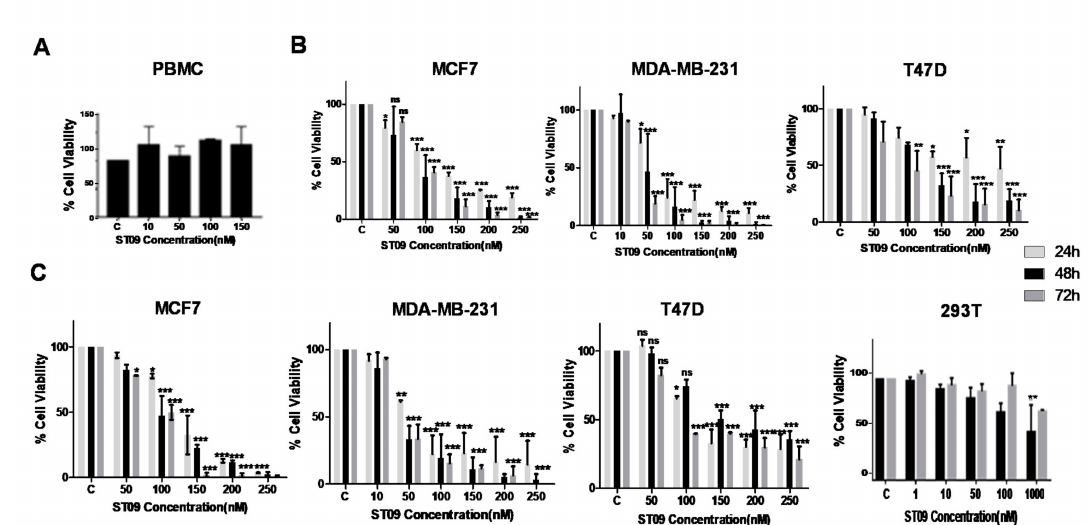
Figure 2. ST09 induced cytotoxicity analysis. ( A ) Viable PBMC cell count after ST09 treatment by trypan blue exclusion: the cells were collected and stained for trypan blue uptake after 48 h treatment with ST09. The unstained viable cells were counted and the percentage of viable cells in each dosage was calculated by considering vehicle control (DMSO) treated cells as 100% viable. ( B ) Evaluation of cell viability after ST09 treatment by LDH assay: bar graph depicting cell viability upon ST09 treatment on three cell lines as tested by LDH assay. ( C ) Evaluation of cell viability after ST09 treatment by MTT assay: bar graph depicting cell viability upon ST09 treatment on cell lines as tested by MTT assay. Data from three di ff erent biological replicates were collected for all experiments and were presented as bar graphs using the Graph Pad Prism tool. Two-way ANOVA followed by Tukey’s multiple comparison test was carried out and significance is represented as **** p -value < 0.0001,